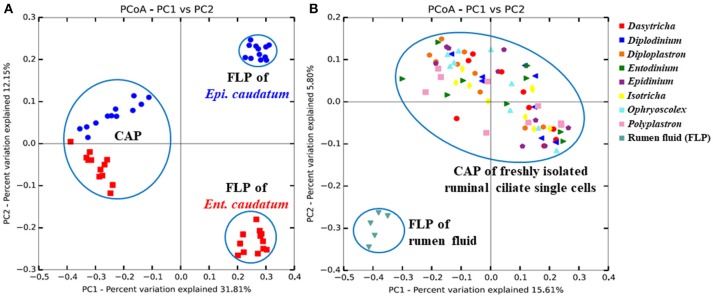
Principal coordinates analysis based on unweighted UniFrac distances in (A) both the FLP and CAP of two ciliate monocultures [Ent. caudatum (red squares) and Epi. caudatum (blue spheres)] and (B) the CAP of fresh isolates of ruminal ciliate singles cells and the FLP of the rumen fluid collected from Jersey dairy cows. Based on ANOSIM, FLP differed (P < 0.001) from CAP of both the monocultures and the rumen fluid.